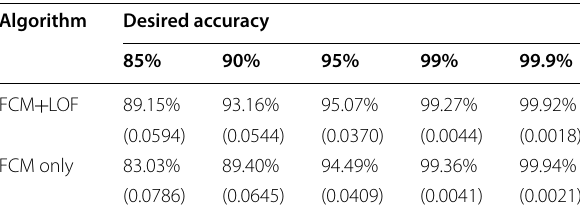
Table 2 Average achieved accuracy over different desired accuracies